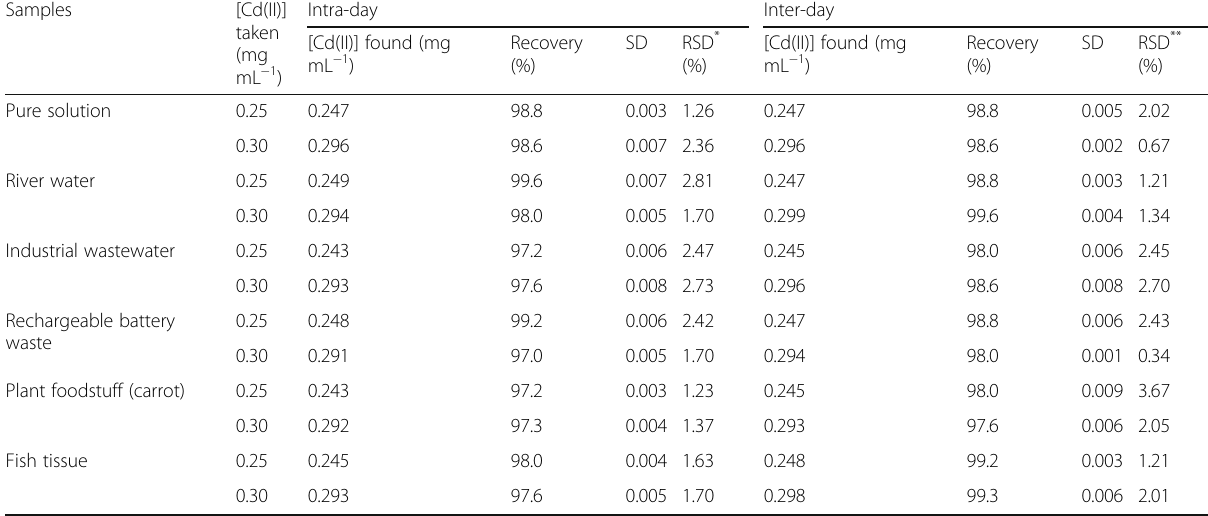
Table 4 Evaluation of intra- and inter-day precision and accuracy of the Cd(II)-CPE sensor